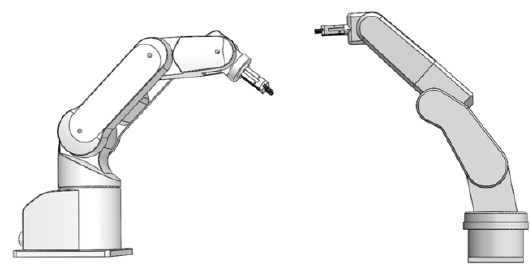
Figure 6. RV-2AJ and RV-2SD robot arms in SolidWorks.